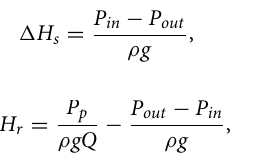
decrease, especially at high flow rates and in the saddle zone 15 . For pumps, a reduction in shaft power is benefi- cial; however, in this study, not only the shaft power decreased but also the total head and efficiency, especially at 30%. Therefore, the high pre-swirl intensity is ineffective for an axial-flow pump, where efficiency and head are prioritized. Consequently, the theoretical analysis and numerical simulation results are similar. The poorer performance before and after the design point is due to the instability in the internal flow caused by low and high flow rates. At the BEP, the efficiency decreased by 4.263% between the 0% and 30% pre-swirl intensity, while the total head and shaft power decreased by 8.267% and 4.183%, respectively. These significant drops at high pre- swirl intensities indicate a significant loss at the IGV passage. Compared to the experimental results, the efficiency of the 30% pre-swirl intensity seems to be the most accurate, with a deviation at BEP of only 0.717%. However, at certain flow rates, such as at the saddle zone, the experimental result yields a higher efficiency than the numerical result. Several losses, such as mechanical losses, shock losses, and leakage losses, were included in the experimental results. Therefore, the efficiency of the experiment should be lower than the numerical result. In addition, comparing the total head and shaft power between the 30% pre-swirl intensity and the experiment shows that the compatibility is poor for the total head and shaft power, which are reduced by 7.114% and 7.644%, respectively, compared to the experimental result at BEP. Consequently, in this study, the inlet flow direction could not achieve 30% pre-swirl intensity. In Fig. 10, the velocity coefficient distributions at 50% span and the low-velocity zone in the IGV passage show the low-velocity zones responsible for the hydraulic loss. The cyan color presents the low-velocity zone, with a velocity coefficient lower than 0.04. The velocity coefficient is defined by its ratio to the impeller tip velocity. The flow directions in front of the IGV obtained by changing pre-swirl intensity are shown with a black arrow in Fig. 10. As the pre-swirl intensity increases, the flow direction tends to become more inclined relative to the rotating shaft due to the increase in the swirl component of circumferential velocity. At high pre-swirl intensity, the low-velocity zone caused by flow separation and recirculation is formed at the SS of the IGV because of the mismatch between flow and blade angle at the LE of the IGV. The formation of the recirculation zone leads to a sharp increase in velocity, and the promotion of instability results in chaos. In addition, this resulted in an unequal velocity distribution at the front of the impeller. Due to the hydraulic loss at the IGV passage, the per- formance was dramatically reduced. To further explore the internal flow loss, the pressure loss proportion of each component of the axial-flow pump under different pre-swirl intensities is shown in Fig. 11. The pressure loss values are normalized by their values at 0% pre-swirl intensity. It can be observed that when the pre-swirl intensity increases, the pressure loss in the IGV passage increases, and the hydraulic performance gradually decreases. Particularly at 30% pre-swirl intensity, a significant drop in the performance of the axial-flow pump is caused by a significant pressure loss in the IGV passage. As a result, the fluid cannot smoothly flow through the IGV, complicating the flow entering the impeller. The total pressure loss is calculated as follows: